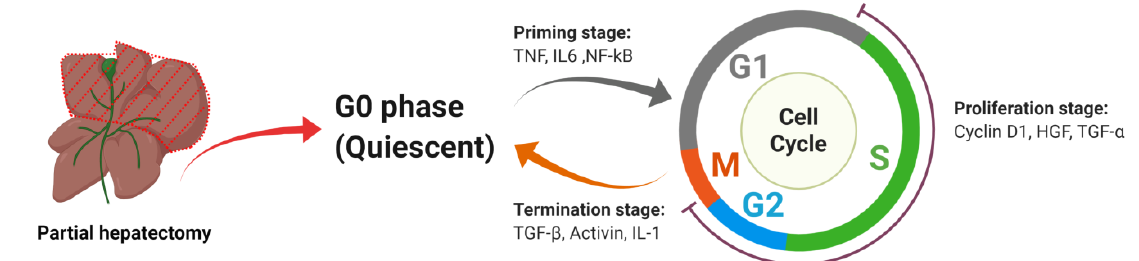
Figure 1. Overview of liver regeneration stages. After partial hepatectomy, every stage is governed by specific transcription factors and cytokines. Under their tight regulation, hepatocytes undergo the process from initiation to termination of proliferation.